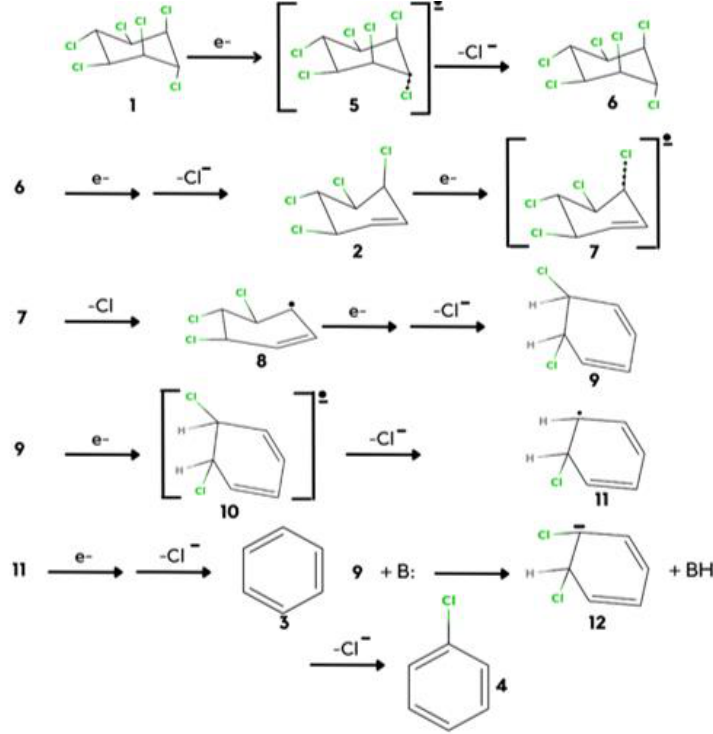
Scheme 2. The electrochemical reduction of